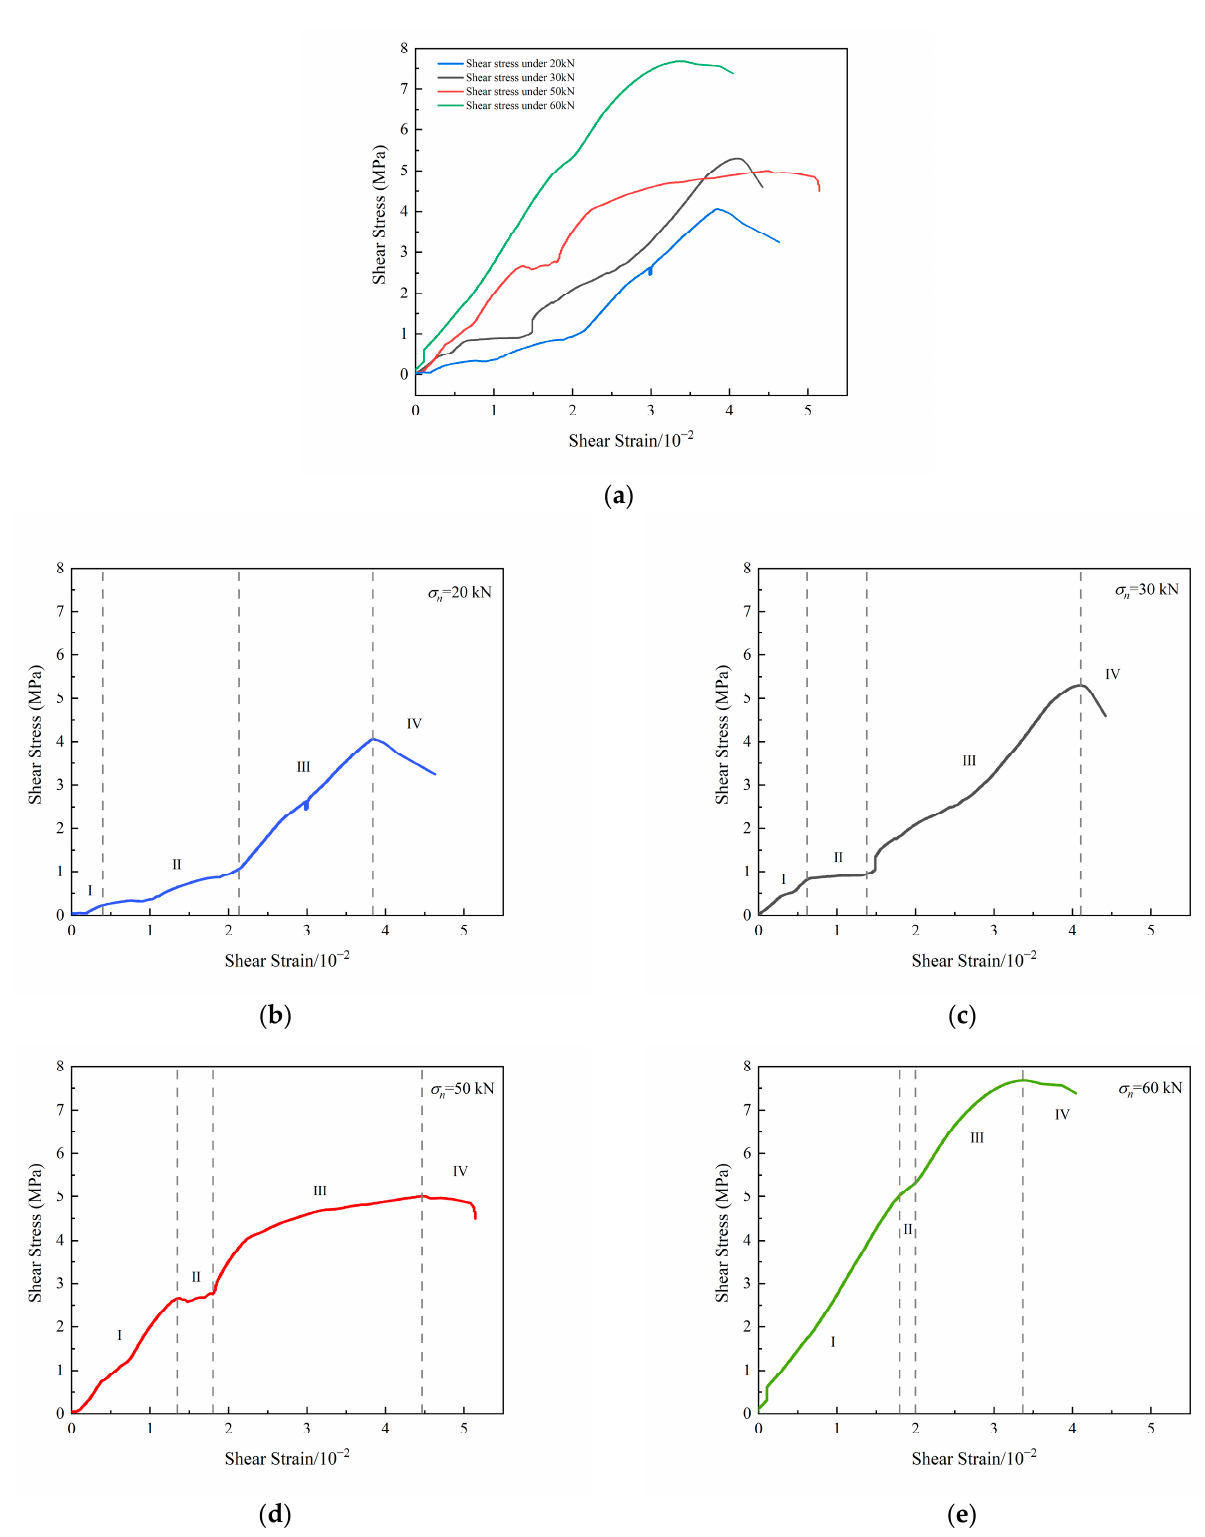
Figure 3. ( a ) Shear stress–strain curves of specimen under constant normal load. ( b ) σ n = 20 kN. ( c ) σ n = 30 kN. ( d ) σ n = 50 kN. ( e ) σ n = 60